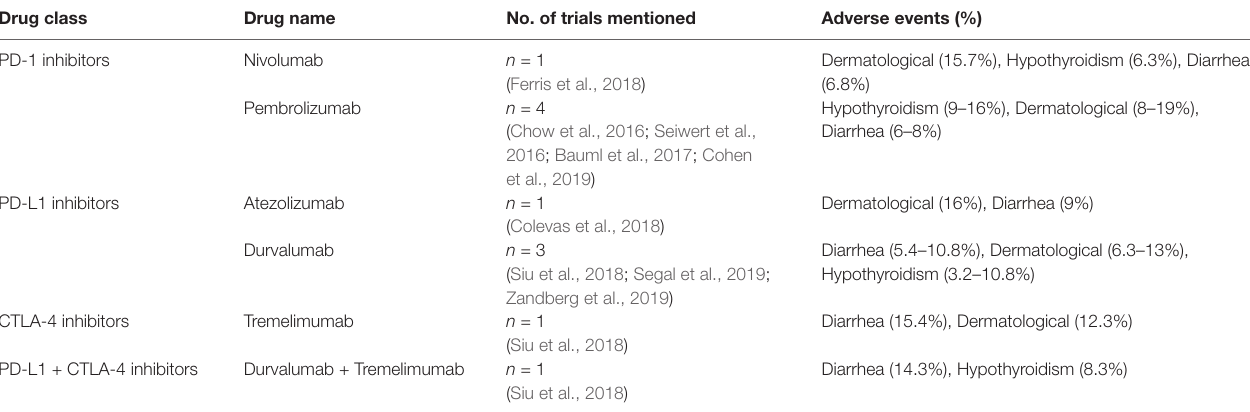
TABLE 2 | List of current ICIs and their associated common toxicities in HNSCC therapy. Drug class Drug name No. of trials